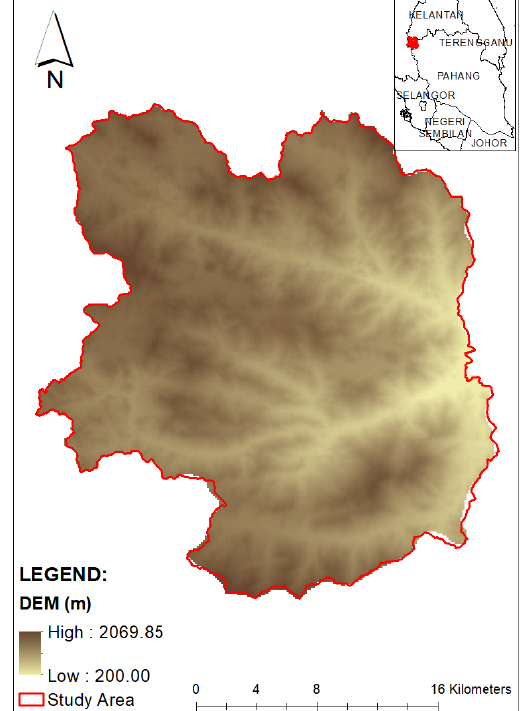
Figure 3. DEM for Cameron Highlands [16].